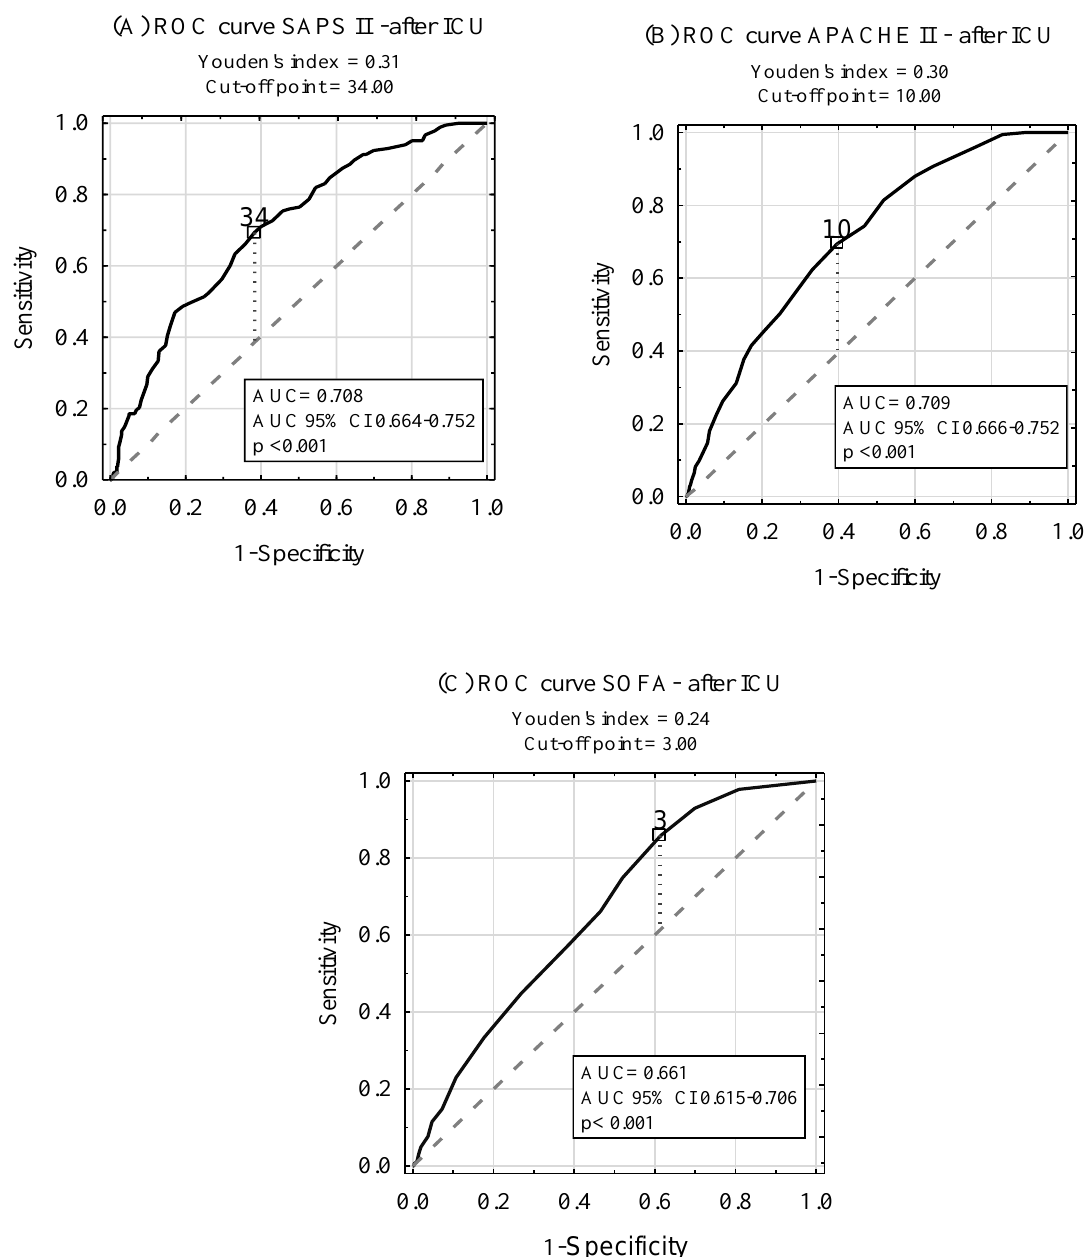
Figure 4. Diagnostic accuracy of SAPS II ( A ), APACHE II ( B ), and SOFA ( C ) scales in post-ICU mortality prediction in ICU survivors.